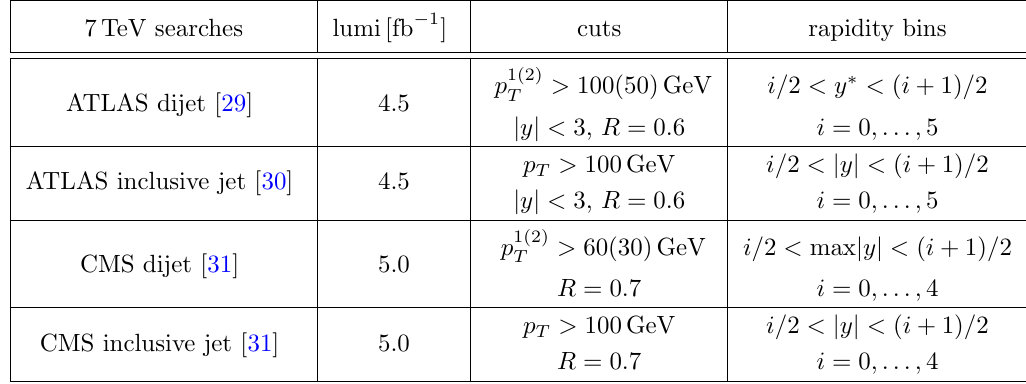
Summary of the experimental searches used for our analysis. The double di(cid:11)erential measurements are always presented in terms of an energy variable (the dijet invariant mass, m jj , for the dijet search and the jet transverse momentum, p T , for the inclusive jet one) and a rapidity variable. The variable y (cid:3) , used by the ATLAS dijet analysis, corresponds to y (cid:3) (cid:17) j y 1 (cid:0) y 2 j = 2, where y 1 ; 2 are the rapidities of the two jets. Notice that y (cid:3) = j log tan ^ (cid:18)= 2 j where ^ (cid:18) is, at leading order, the scattering angle in the center of mass frame. R is the jet